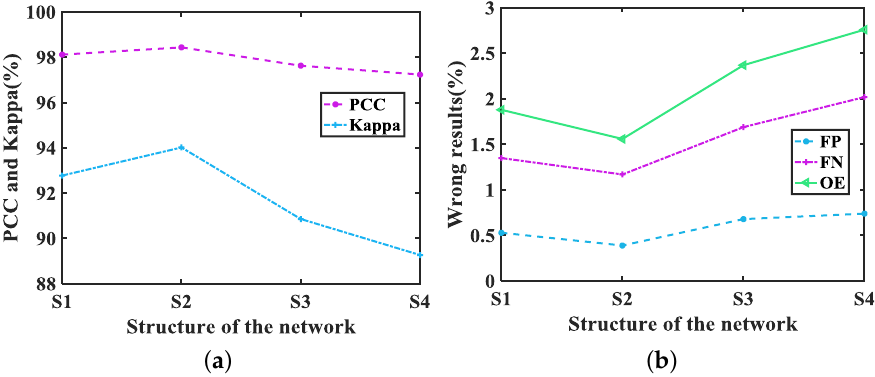
Figure 28. The influence of different structures on change detection results in Ottawa data set. ( a ) Values of PCC and Kappa. ( b ) Values of FP, FN and OE. S1 denotes the structure 9-50-1, S2 denotes the structure 9-100-50-1, S3 denotes the structure 9-100-200-50-1, S4 denotes the structure